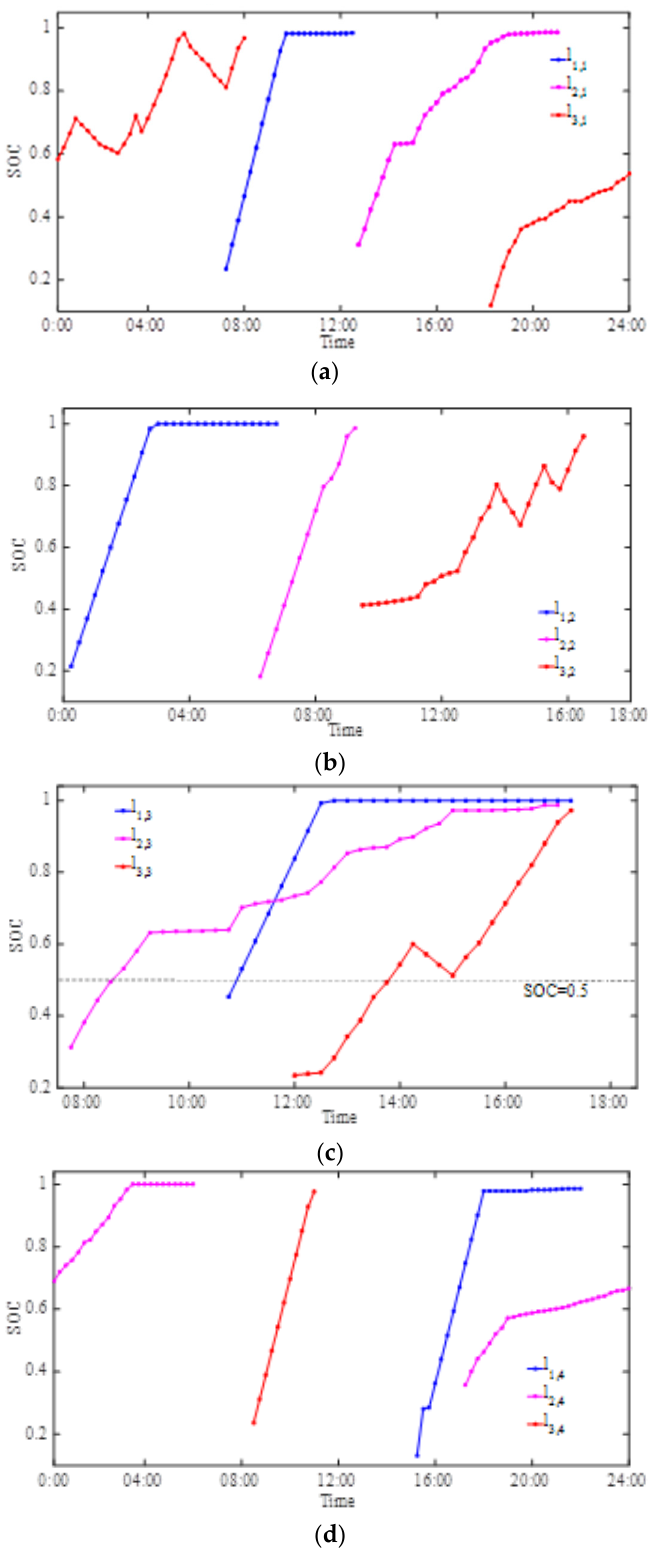
Figure 10. Three SOC change curves of three EV types in four EVAs. ( a ) SOC changes of three EV types in A 1 ; ( b ) SOC changes of three EV types in A 2 ; ( c ) SOC changes of three EV types in A 3 ; ( d ) SOC changes of three EV types in A 4.